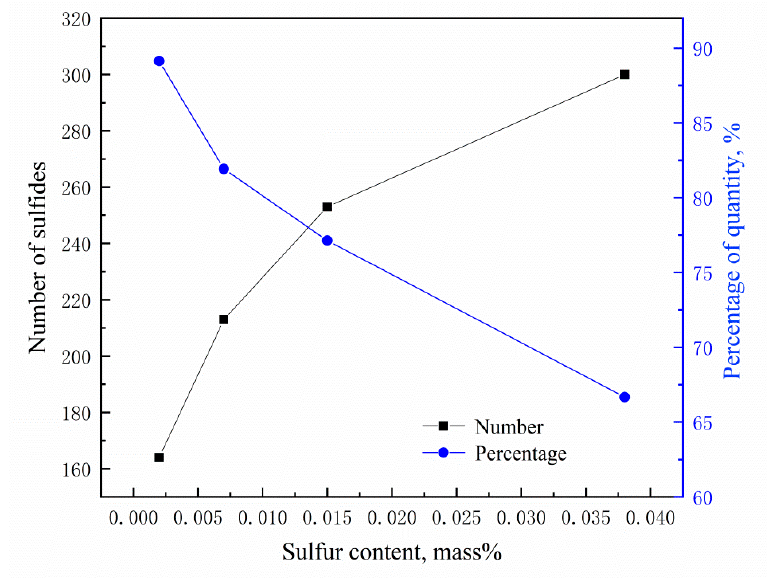
Figure 8. Number of MnS inclusions (left y-axis) and percentage of them with aspect ratio < 2 (right y-axis) in steels with different sulfur contents.